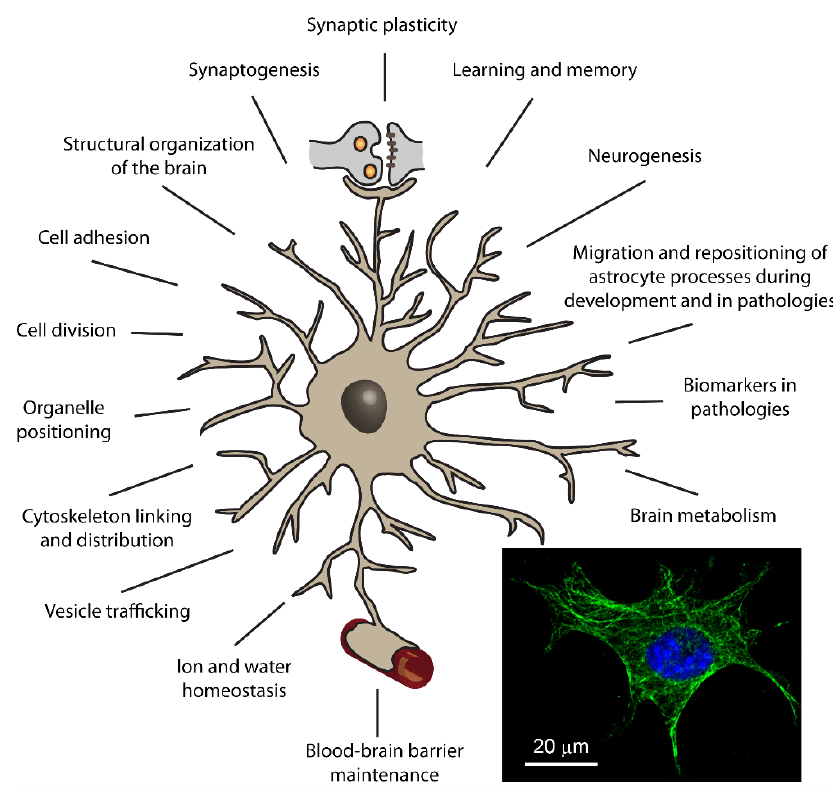
Figure 3. Putative roles of plectin in astrocytes. The figure depicts an astrocyte, a type of glial cell that, on the one hand, together with the pre- and postsynaptic membrane constitute the so-called tripartite synapse (depicted at the top of the figure), and on other hand, enwrap brain capillaries (indicated at the bottom of the figure). Presumed roles of plectin in astrocytes are summarized around the astrocyte. Based on today’s knowledge of plectin, derived from other cell types and biochemical studies, and cytoskeleton elements in the CNS, we propose that plectin plays crucial roles in a number of intracellular processes of astrocytes, which are also related to the functioning of other brain cells, such as endothelial cells and neurons. By affecting tissue morphology and physiology, plectin in astrocytes may have a prominent impact on higher order functions of the CNS, such as learning and memory formation. Inset: image of a mouse astrocyte in culture with immunolabelled plectin (green labelling) and DAPI-labelled cell nucleus (in blue). Note that the plectin signal results in a pronounced filamentous distribution, which likely denotes binding to the cytoskeleton.